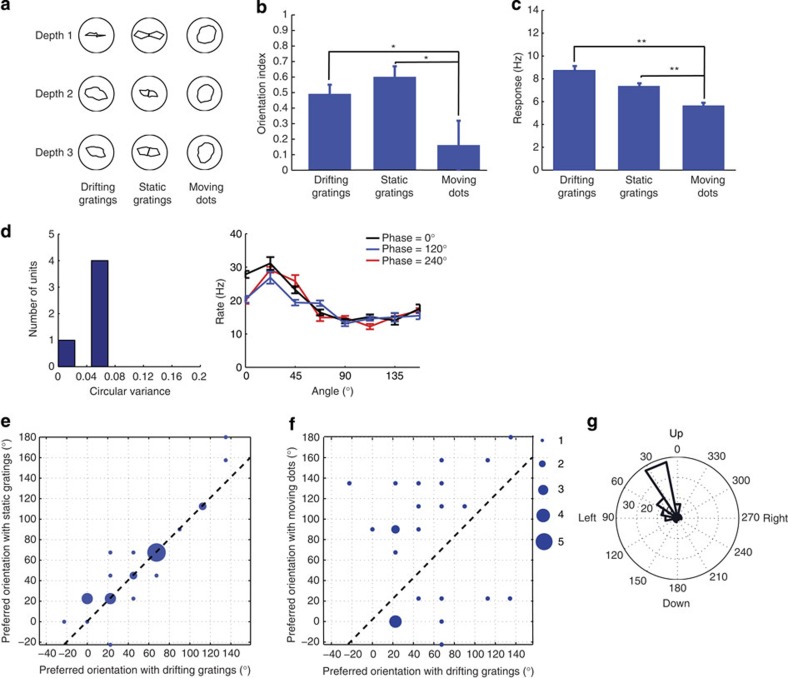
Columns are organized by orientation not by direction.(a) Example penetration with tuning for drifting gratings, static gratings and moving dots. For static gratings, the results for any direction and its opposite are the same, and presented only for comparison. (b) Orientation selectivity for static and drifting gratings is similar (P=0.24, t-test, drifting n=28 multi-units, static n=26, 5 mice) and is lower for moving dots (P=0.01 for static, P=0.046 for drifting, dots n=25). Error bars are mean±s.e.m. (c) Mean responses during stimulus presentation are highest for drifting gratings, and similar for static gratings and move dot displays (P<0.01 for moving dots compared to drifting and static gratings). (d) Histogram of circular variance of preferred orientation of each unit over different phases of static gratings (n=5 multi-units, 2 mice; left) and firing rate of an example unit over different angles of the static gratings with three different phases. (e) Orientation preference for drifting and static gratings is similar (n=26, 5 mice). Size of the dots indicates the number of the units with the same preferred orientation. (f) Orientation preference for drifting gratings and moving dots is different (n=25 multi-units, 5 mice). (g) Direction-selective units (DSI>0.5, left hemisphere) prefer upward motion (P<10−5, Rayleigh test for circular non-uniformity, n=72, 6 mice).